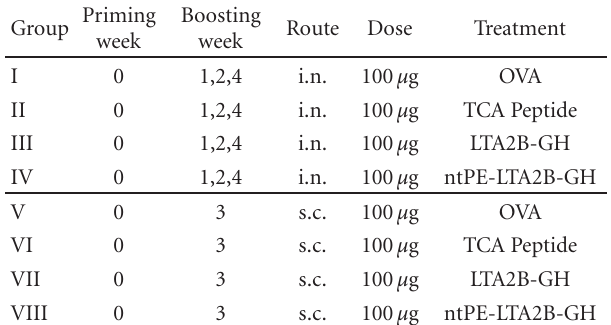
Table 1: Vaccination strategy for guinea pig